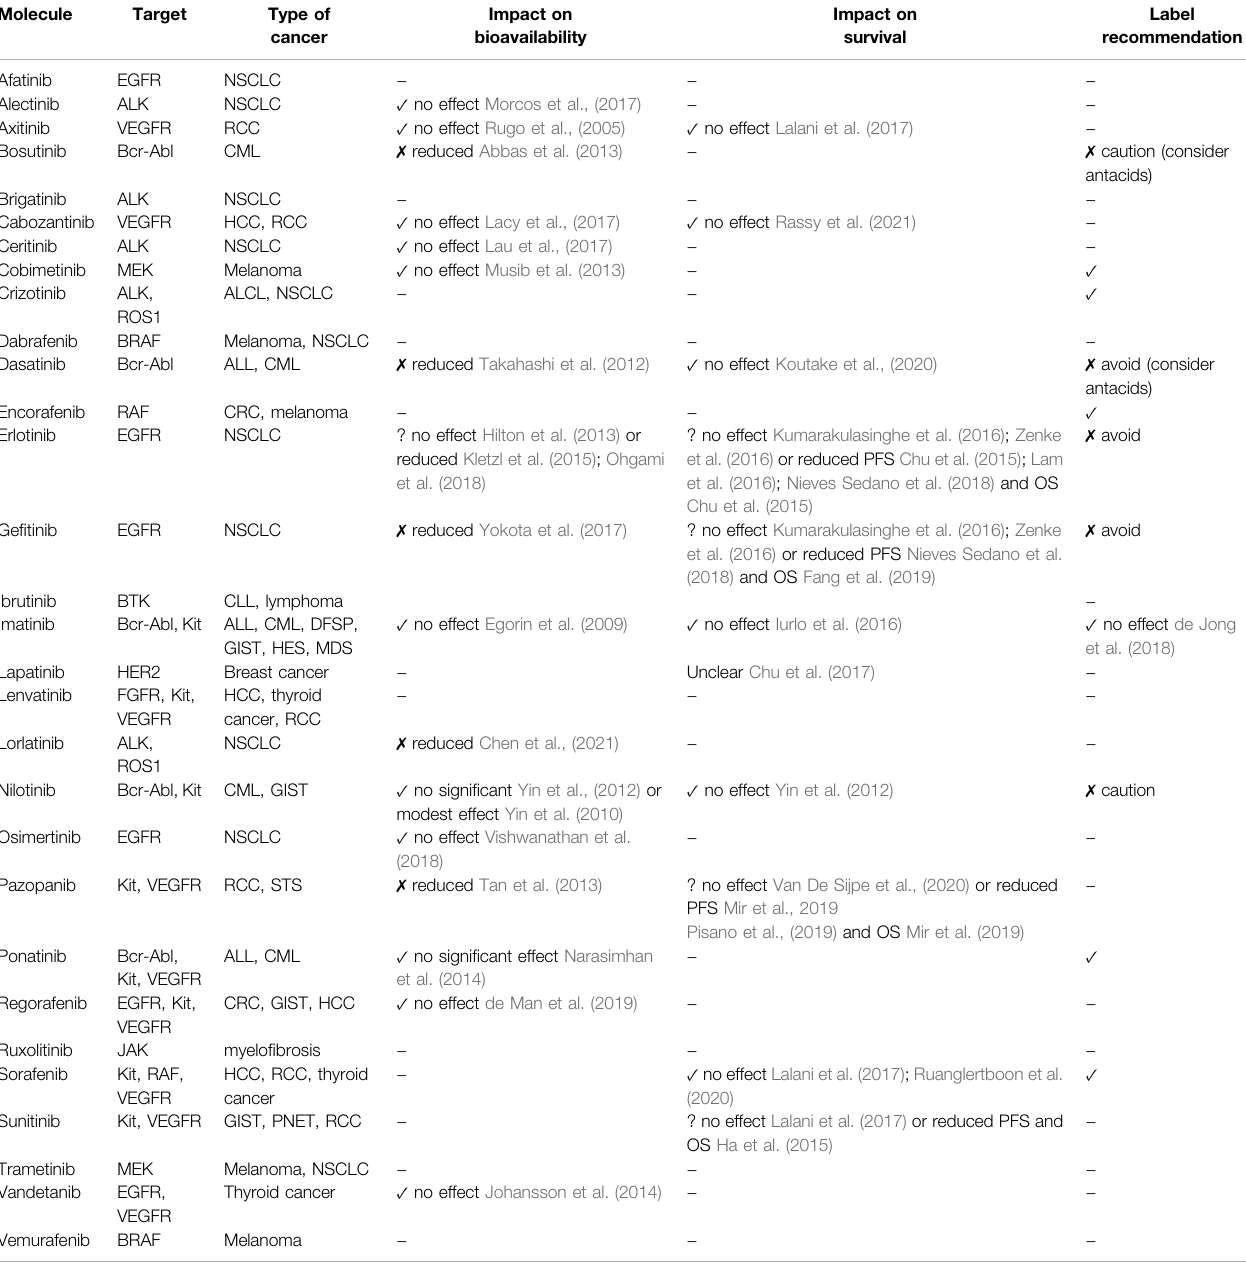
TABLE 3 | Summary of drug – drug interactions between proton pump inhibitors and tyrosine kinase